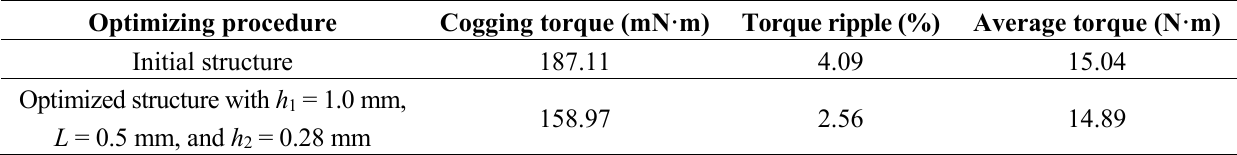
Table 2. Torque characteristics before and after the notched teeth